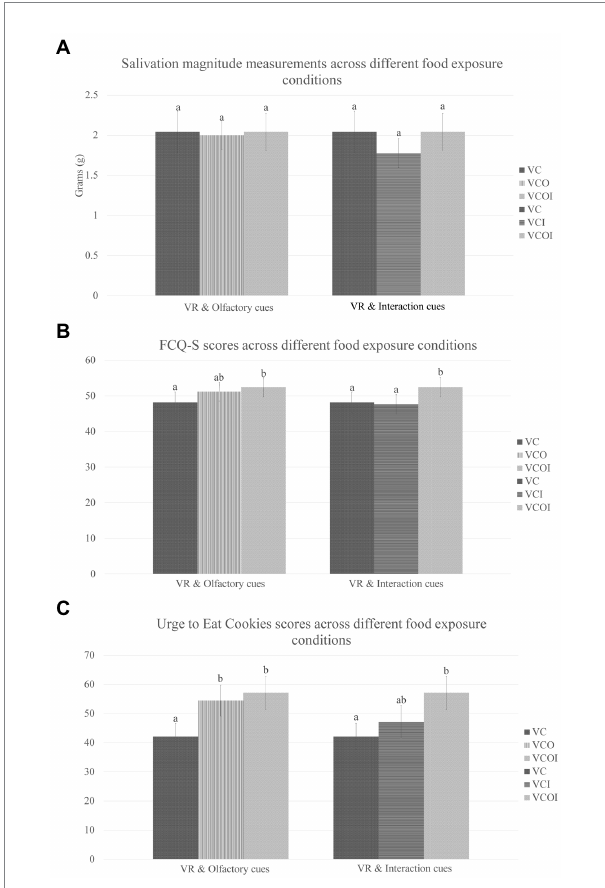
FIGURE 4 Means and standard errors of food craving measures comparing the effects of VR olfactory and interaction cues. (A) Results for Salivation Magnitude (measured in grams); (B) Results for FCQ-S - Food craving questionnaire state (scores from 15 to 75); (C) Results for UC – Urge to eat cookie (scores from 0 to 100). VC, Virtual Cookie; VCO, Virtual Cookie and Olfactory Cues; VCI, Virtual Cookie and Interaction; VCOI: Virtual Cookie, Olfactory Cues and Interaction. Means that do not share a letter are significantly